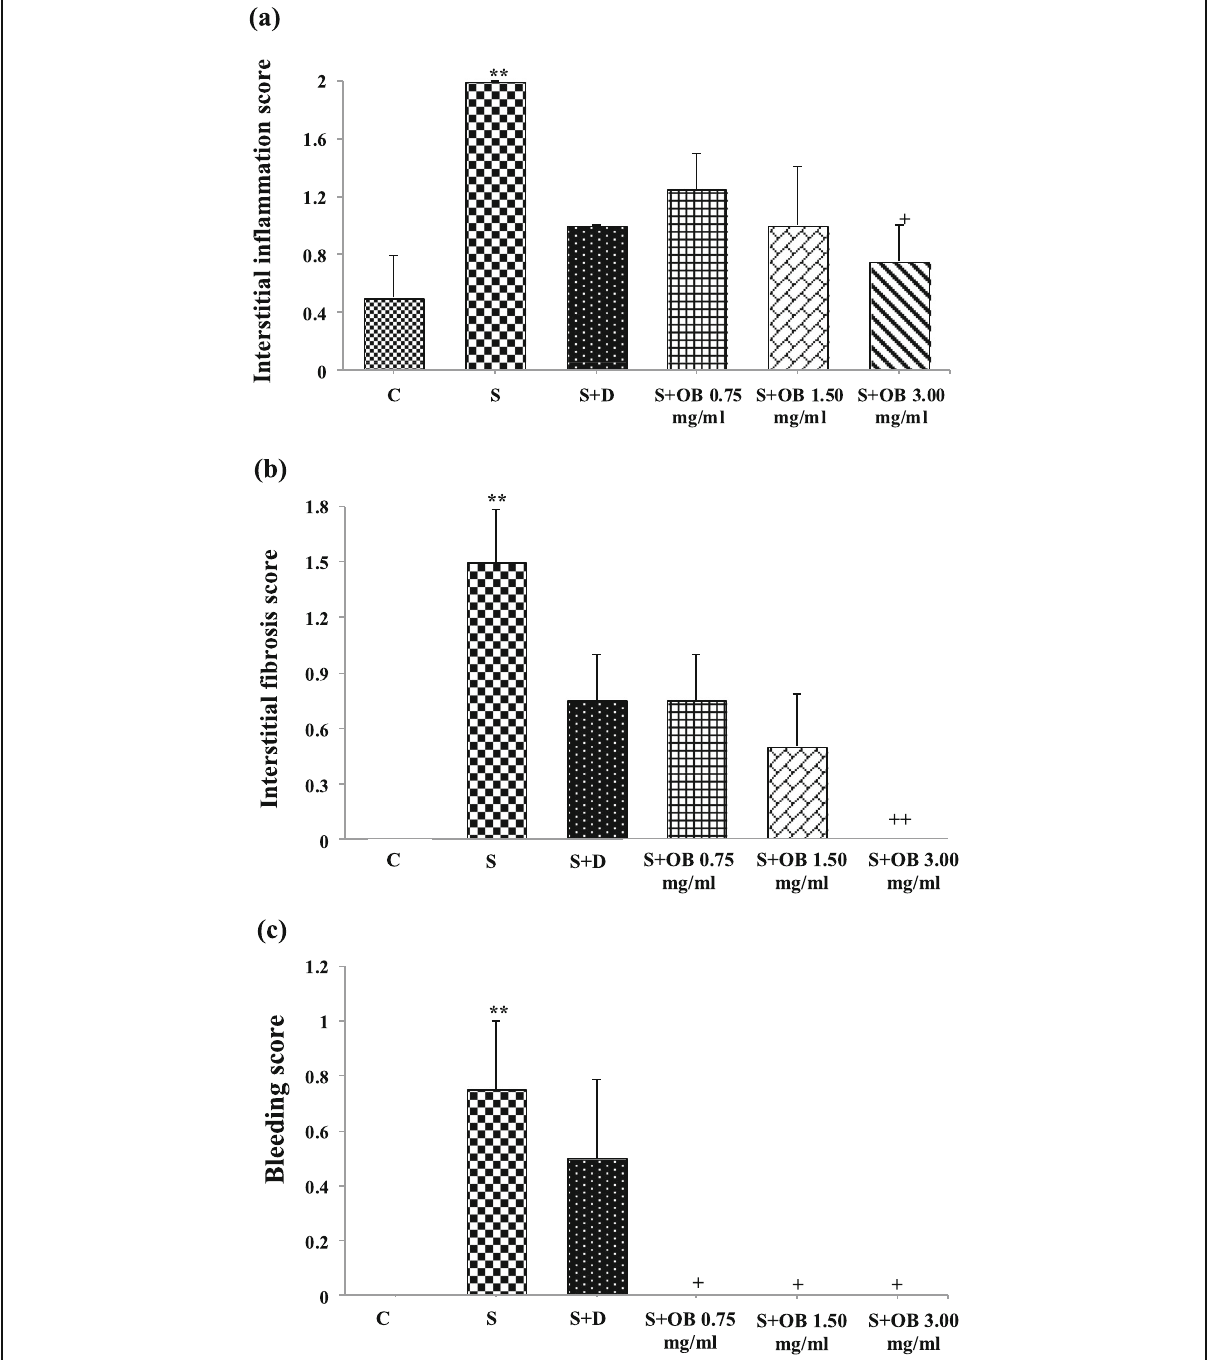
Fig. 7 The score of interstitial inflammation ( a ), interstitial fibrosis ( b ) and bleeding ( c ) in the control (C), sensitized (S), treated sensitized animals with dexamethasone (S + D) and three O. basilicum concentrations (S + OB) groups, (in each group, n = 8). *: P < 0.05, **: P < 0.01, comparison with C group. +: P < 0. 05, ++: P < 0.01, comparison with S group. One-way analysis of variance (ANOVA) with Tukey-Kramer ’ s post-test was used